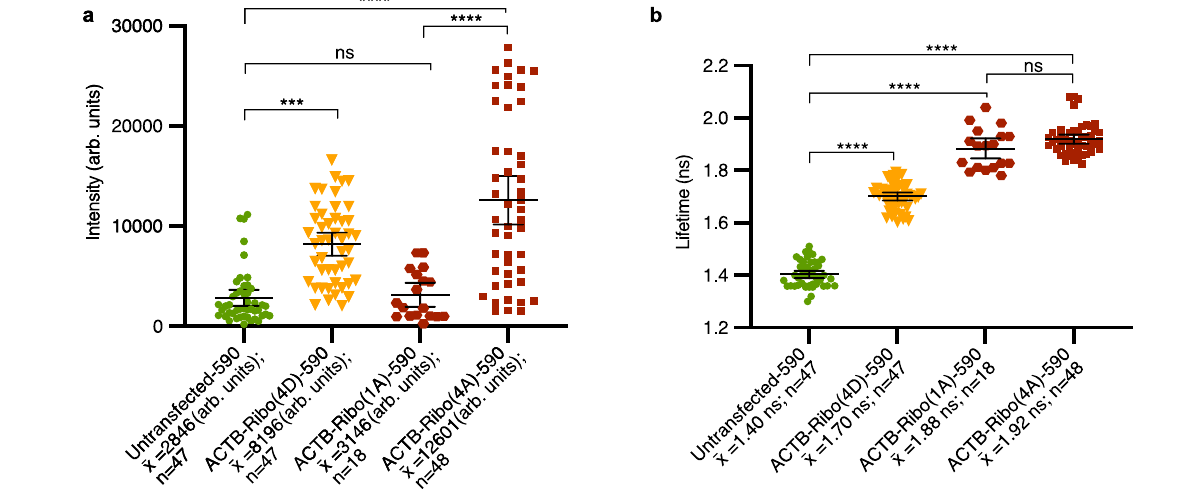
intensity ( a ) or average fl uorescence lifetime (as de fi ned in Fig. 2) ( b ) were extracted (6 independent experiments, 160 cells, 1 symbol = 1 cell). (ns: p ≤ 0.5; * p ≤ 0.05; ** p ≤ 0.01; *** p ≤ 0.001; **** p ≤ 0.0001, see Supplementary Table 4). One- way ANOVA (95% con fi dence limit); post hoc test (Tukey HSD). Error bars indicate mean and standard deviation (+/ −